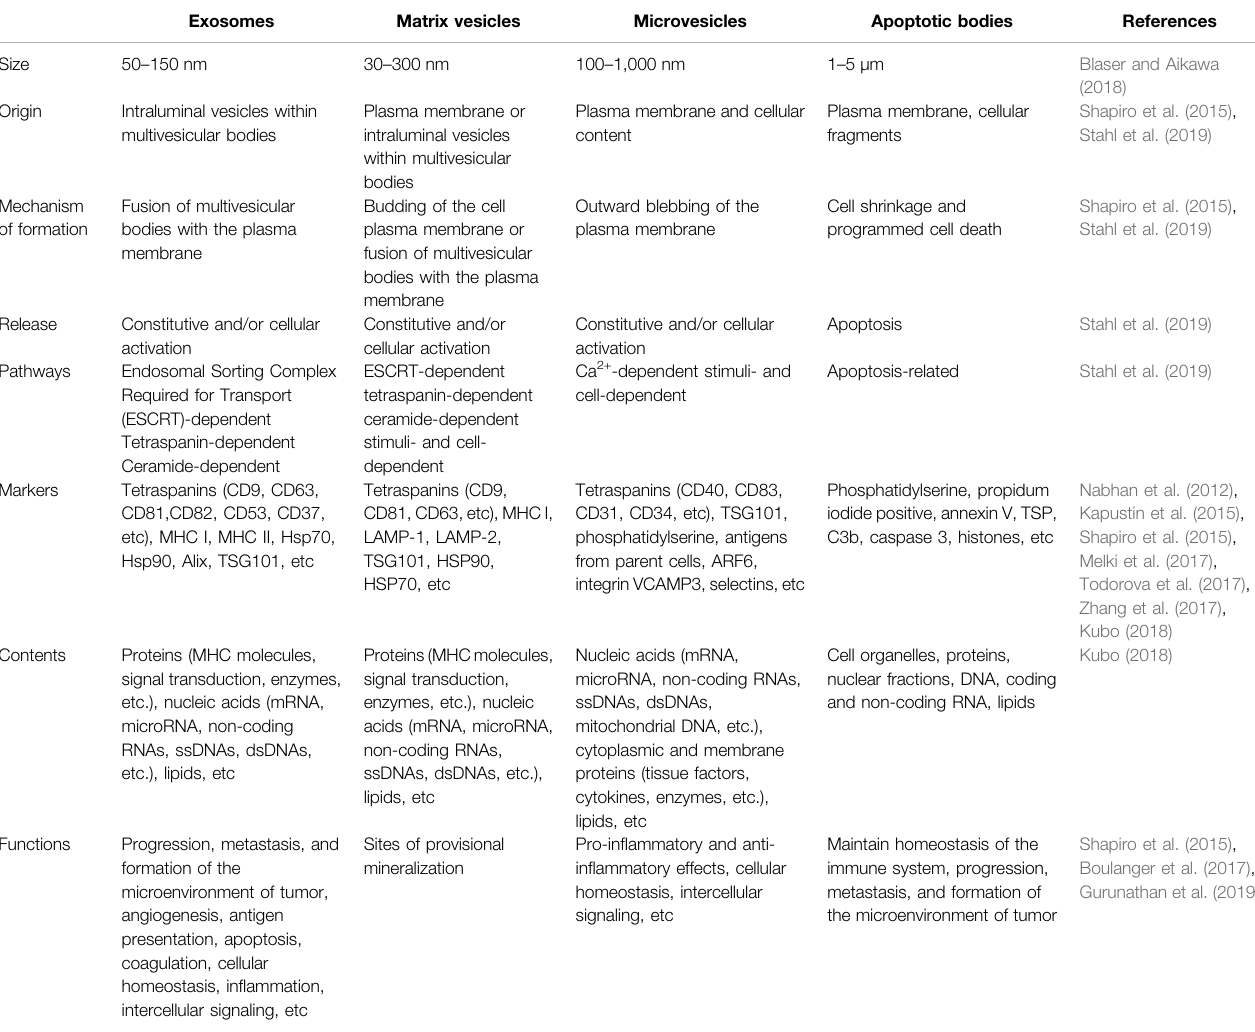
TABLE 1 | Main characteristics of exosomes, matrix vesicles, microvesicles, and apoptotic